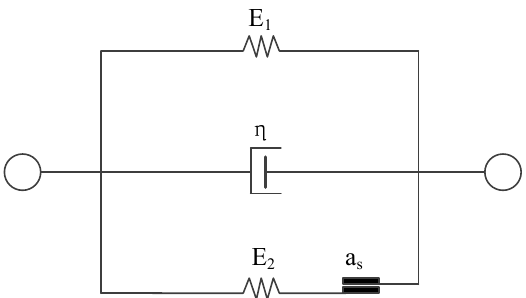
Figure 1. Configuration of the constitutive model for viscoelastic-plastic rock-like